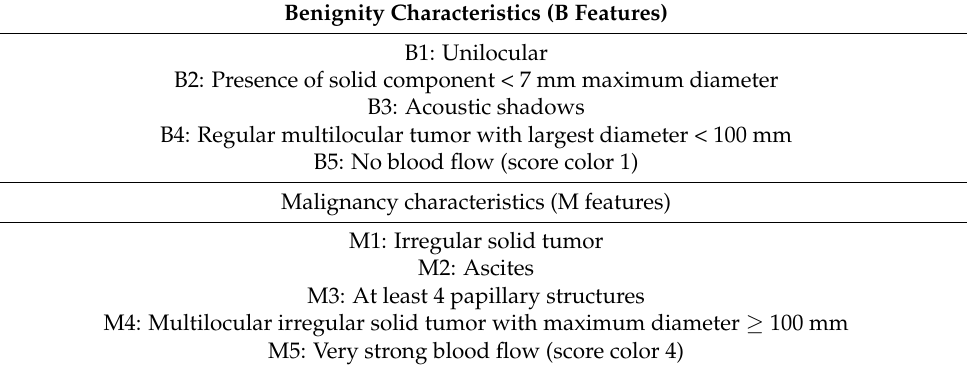
Table 1. IOTA Simple